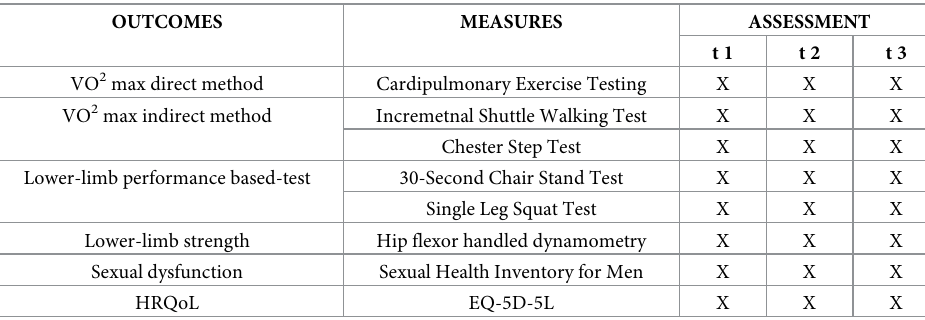
Table 1. Outcomes, measures, and assessment methods that will be used in this clinical trial. OUTCOMES